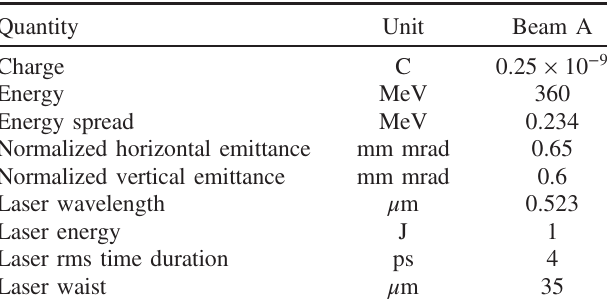
TABLE III. Main parameters of electron and laser beams for ELI project [13].